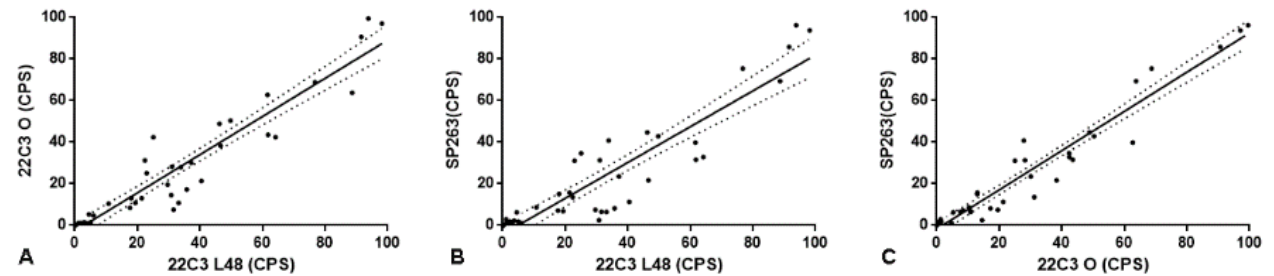
Figure 3. ( A ): the figure shows the direct and significant correlation between CPS evaluated with 22C3 pharmaDx on Dako Autostainer link48 and Dako Omnis (O; Spearman r = 0.900 p < 0.0001). ( B ): the figure shows the direct and significant correlation between CPS evaluated with 22C3 pharmaDx on Dako Autostainer link48 and SP263 assay (Spearman r = 0.893 p < 0.0001). ( C ): the figure shows the direct and significant correlation between CPS evaluated with 22C3 pharmaDx on Dako Omnis (O) and SP263 assay (Spearman r = 0.935; p < 0.0001).